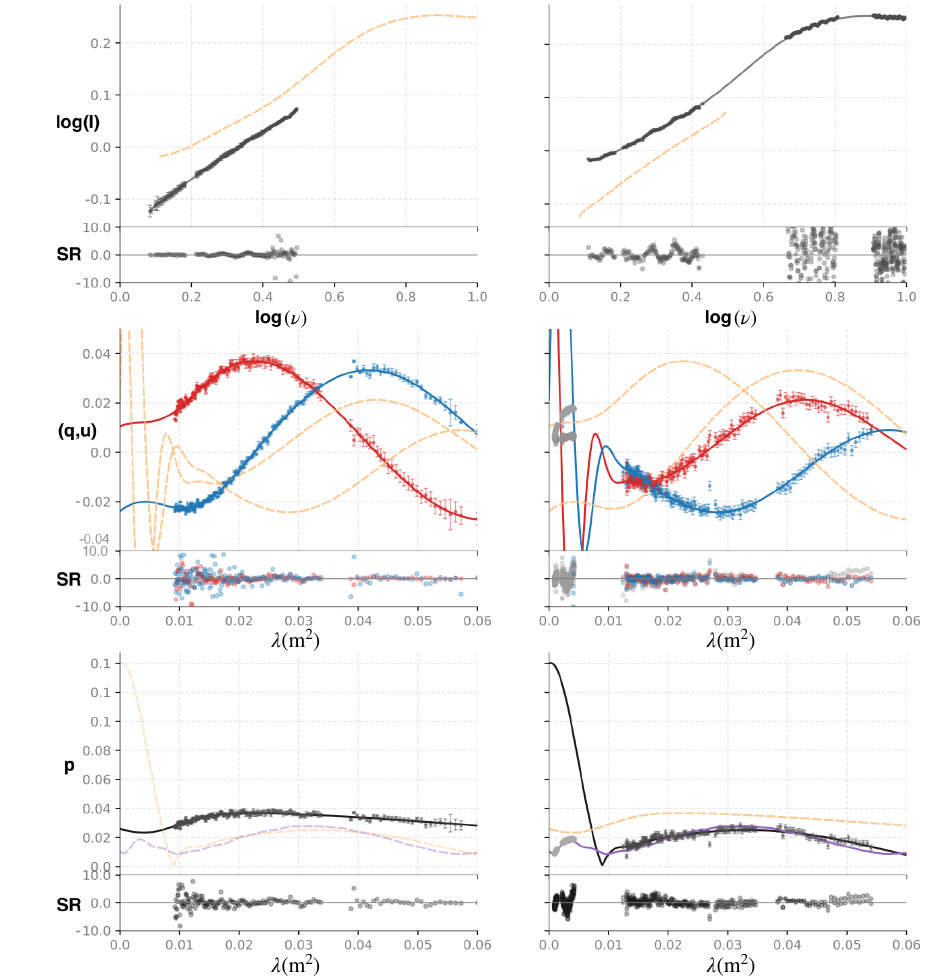
Figure 3. Stokes I data (black points, top row of panels), Stokes q and u data (red and blue points, middle row) and fractional polarisation data ( p , black points, last row) for PKS B0454-810 in the 2012 and 2017 epochs (left and right column of panels, respectively). To facilitate comparison between epochs, the best-fit model for both the 2012 and 2017 epochs are mirrored on the opposite epoch axes as dashed orange lines for each of the Stokes I , ( q , u ), and p plots. Straight lines (black, red and blue) are the best model fit. The sub-axes on each panel are the standardised residuals (measured in standard deviations) for the difference between the data and the best-fit model. Image adapted from